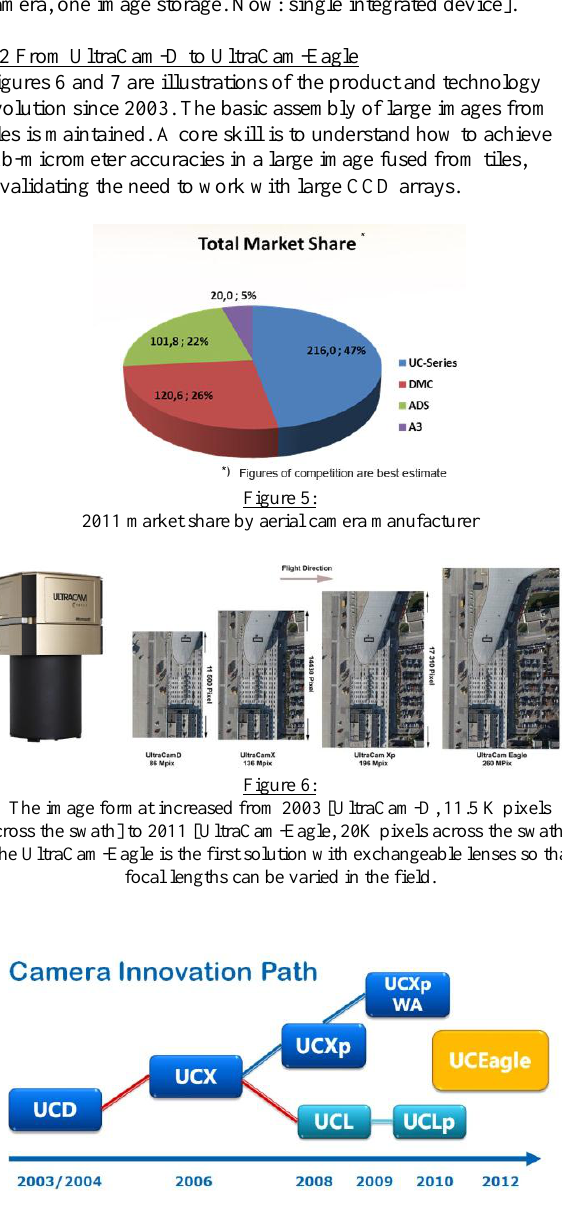
Figure 7: The UltraCam-family of products and their evolution over